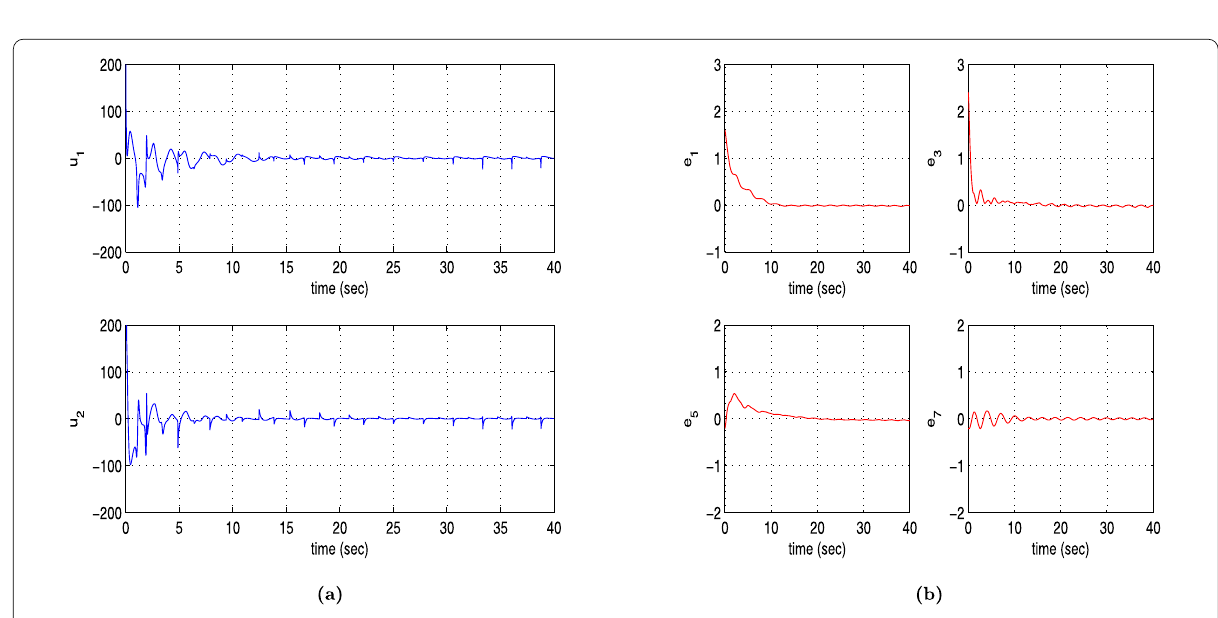
Figure 18 Tracking of setpoint 8 for the tower crane ( a ) control inputs u 1 , u 2 applied to crane, ( b ) tracking error variables e 1 , e 3 , e 5 , e 7 of the tower crane